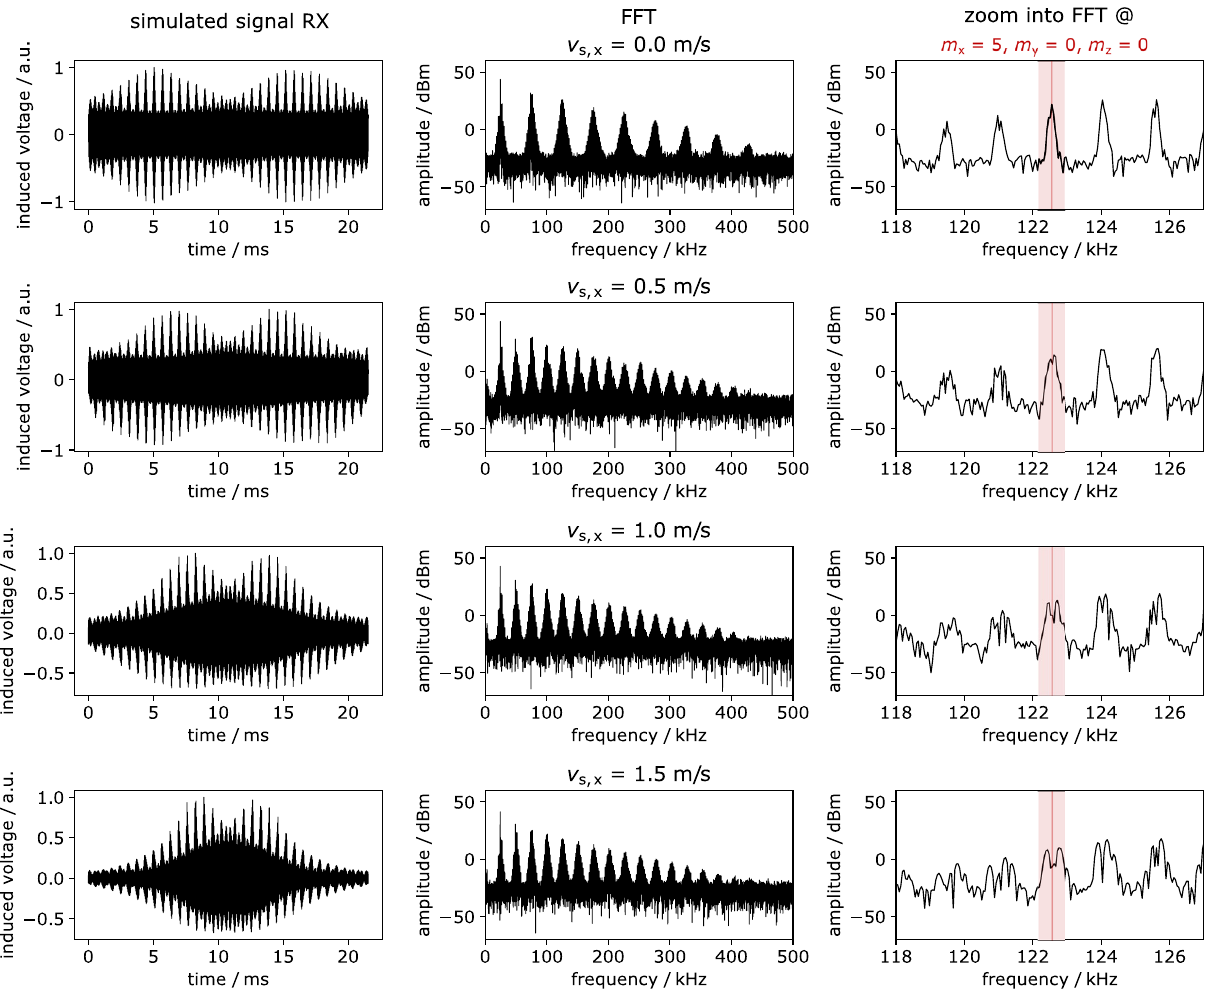
Figure 5. Simulated signal of moving tracer scanned by 3D-Lissajous FFP trajectory. Signal induced into the Rx-channel (receive coil is sensitive to magnetization changes in x -direction) of uniformly moving sample in x -direction in time (left) and frequency domain (center, right) for different sample velocities: { 0, 0.5, 1.0, 1.5 } m/s. The drive field frequencies are f x = 24.5098 kHz, f z = 26.04167 kHz and f z = 25.2525 kHz, resulting in a 3D Lissajous trajectory with a repetition time of 21.55 ms as implemented in the preclinical MPI Bruker 25/50 (Bruker BioSpin GmbH, Ettlingen, Germany). The other relevant simulation parameters were as well aligned to the Bruker device: H Dx,y,z = 14 mT /µ 0 , G x = 2.5 T/m, G y,z = 1 2 G x , x max FFP = 5.6 mm, y max FFP = z max FFP = 11.2 mm, m 0 = 3.35 · 10 − 18 Am 2 , T = 293 K. The images on the right show that the frequency splitting is visible for sample velocities unequal to zero at the frequency component resulting from the mixing factors m x = 5, m y = 0 and m z =